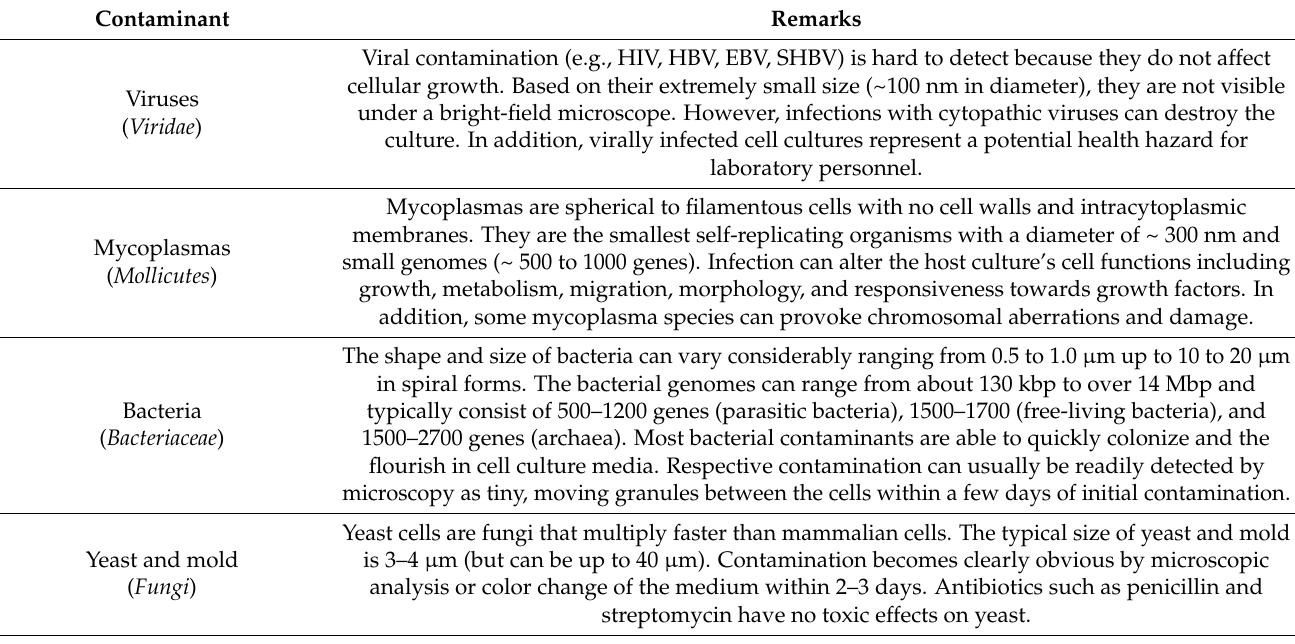
Table 2. Widespread cell culture